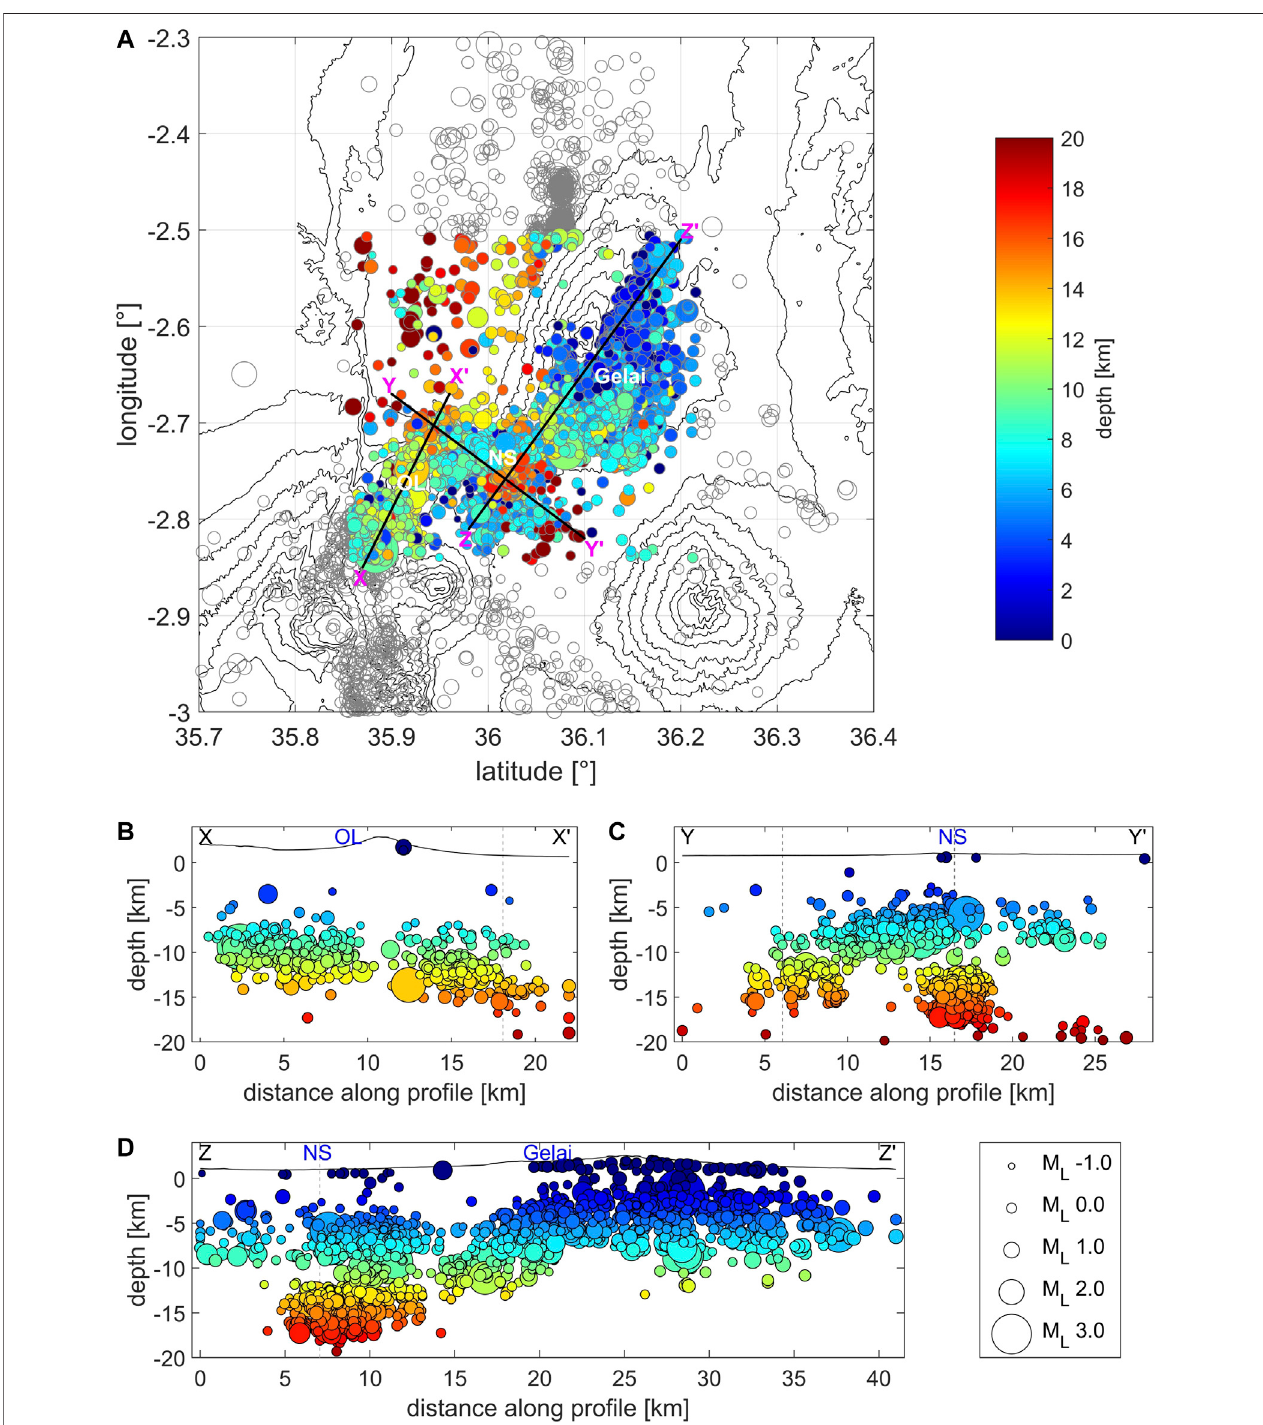
FIGURE 5| (A) Map view of well-located earthquakes scaled bytheir magnitude and colored bytheir depth. (B) Enlarged verticalcross-section along the pro fi le of X-X ’ . (C) Enlarged vertical cross-section along the pro fi le of Y-Y ’ . (D) Enlarged vertical cross-section along the pro fi le of Z-Z ’ . Intersections between pro fi les are marked with a gray dashed line. Color scale is saturated at 20 km for better visibility, as few events occur beneath 20 km depth.